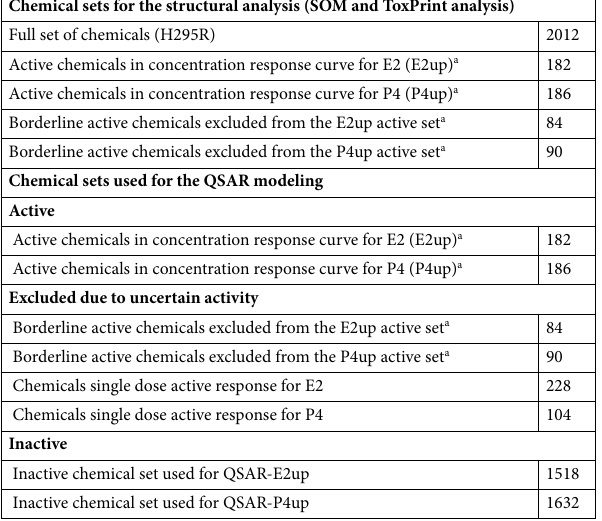
Table 1. Summary of chemical sets used for this work. a Chemicals identified as active or borderline in H295R concentration–response by ANOVA as described in Cardona